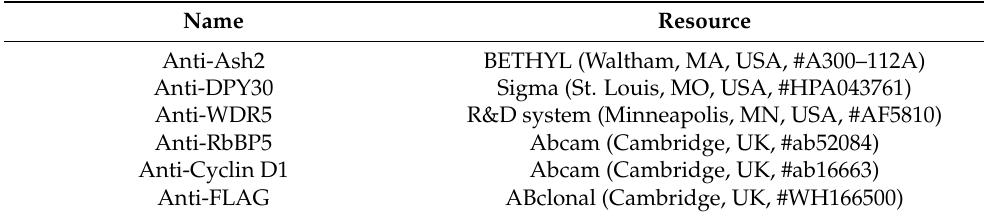
Table 2. Antibodies used in the